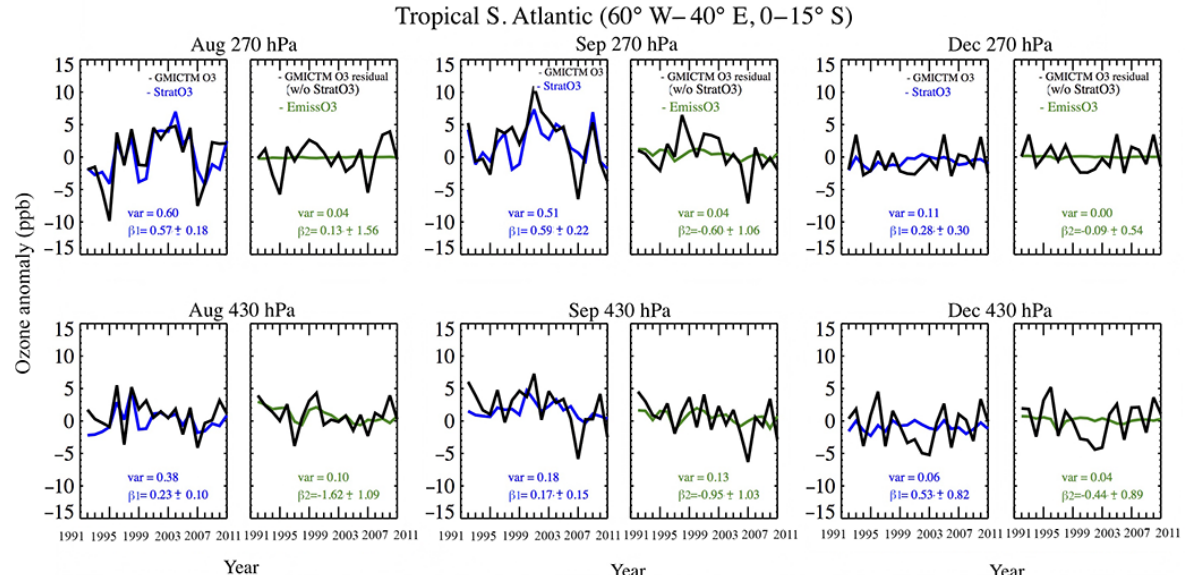
Figure 14. The multi-regression results of simulated ozone anomalies over the tropical South Atlantic region relying on StratO 3 (blue) and EmissO 3 (green) at 270 and 430hPa. Three panels show results from August (left), September (middle), and December (right) from 1992 to 2011. Each panel contains two columns. The left column of each panel compares the anomalies of StratO 3 (blue) and simulated ozone mixing ratio (black) from the GMI-CTM model at 270 and 430hPa. The right column compares the simulated O 3 residual after removing the regression from StratO 3 (black line) and EmissO 3 (green line) at these two levels. EmissO 3 is calculated from the difference of simulated ozone between the run with yearly-varied emission and the run with constant emission. Unit for y axis is parts per billion (ppb). The variance explained by each predictor (var), regression coefficient ( β) , and its 95% confidence level are labeled in each